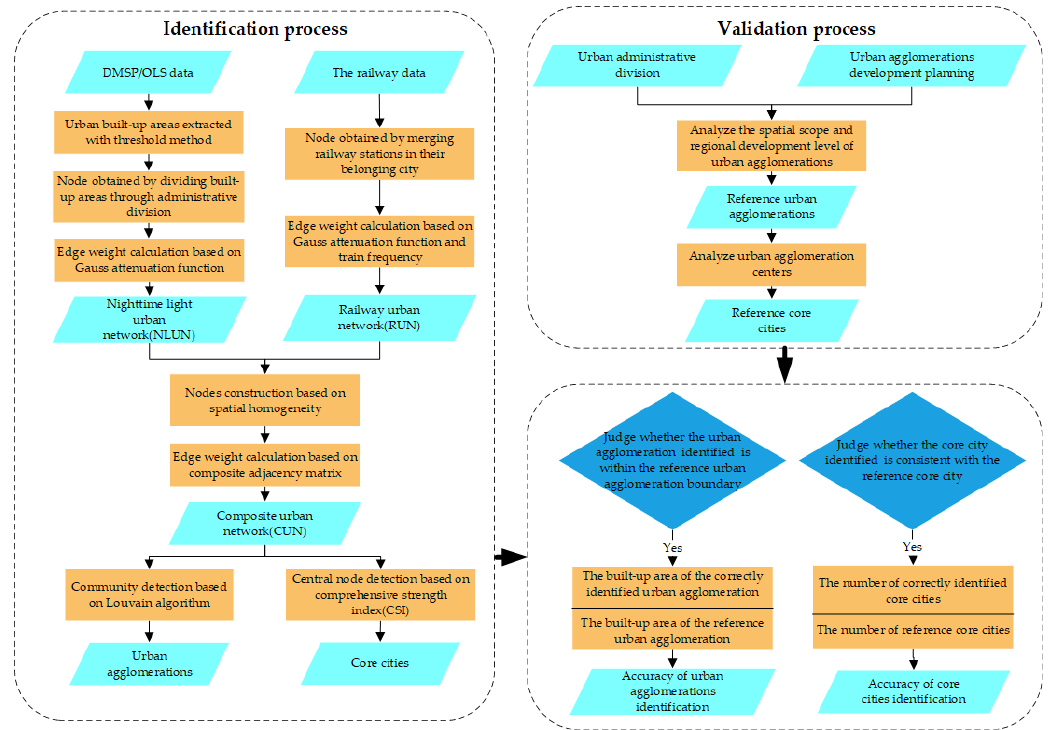
Figure 4. Flowchart of the proposed spatial structure method for identification of urban agglomerations.